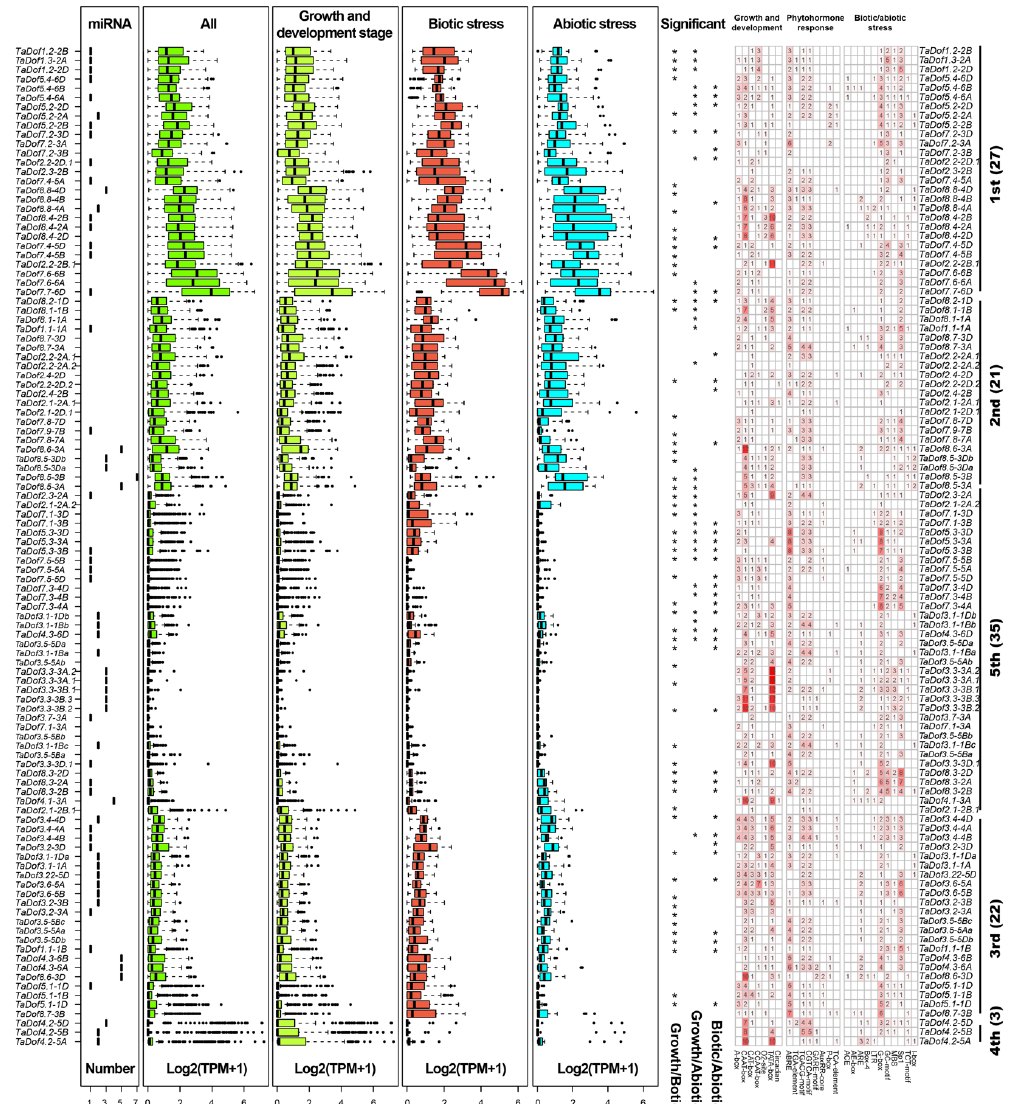
Figure 7. Integration of expression profiles, miRNAs, and cis -elements. Box “All” contained all